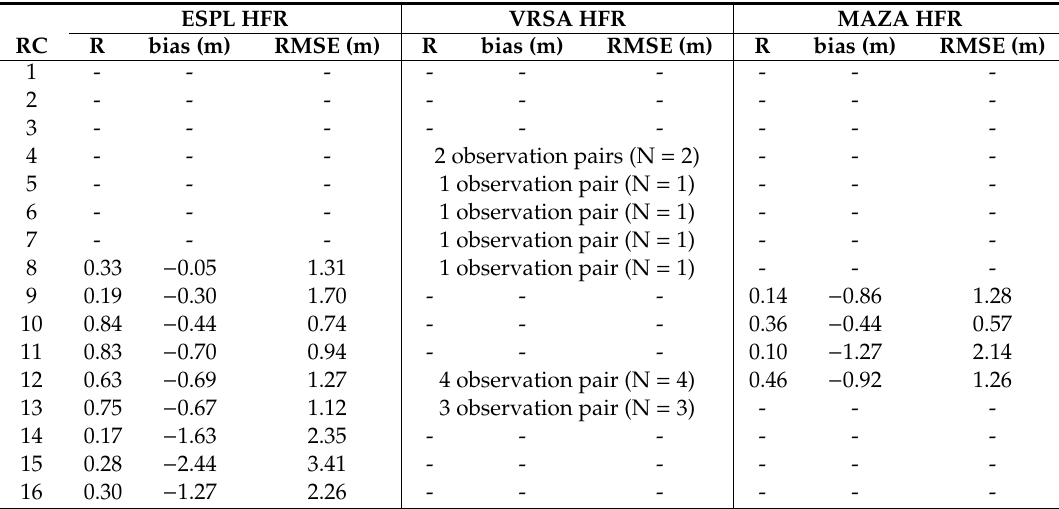
Table A6. Correlation (R), bias and RMSE (statistic metrics) between SRAL and HFR SWH for each RC, considering the distance from the coast; 12–13.5 MHz HFR sites (ESPL, VRSA, and